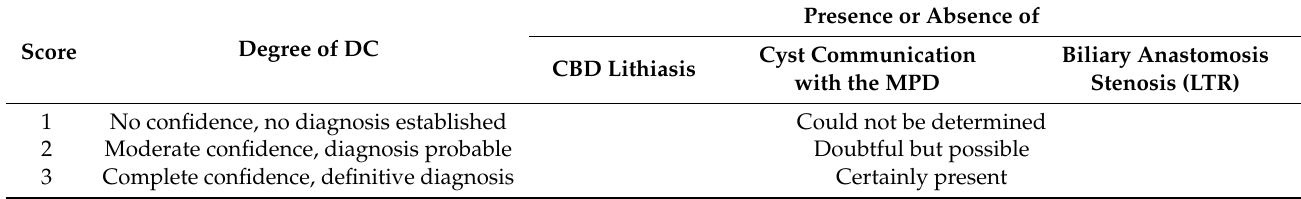
Figure 2. The segments of the pancreatic and bile ducts on a MIP reconstruction image acquired with the CS-BH-MRCP sequence for qualitative image quality analysis. Numbers represent the main pancreatic duct (MPD) and bile ducts: (1) distal common bile duct (CBD), (2) proximal CBD, (3) cystic duct confluence, (4) left primary intrahepatic bile duct (IBD), (5) right posterior sectoral IBD, (6) right anterior sectoral IBD, (7) distal MPD, (8) central MPD, (9) proximal MPD. Left medial and left lateral ducts are not represented on this figure. Note that no right primary IBD duct was present in this patient. Table 3. Likert scale used to evaluate the degree of confidence in the